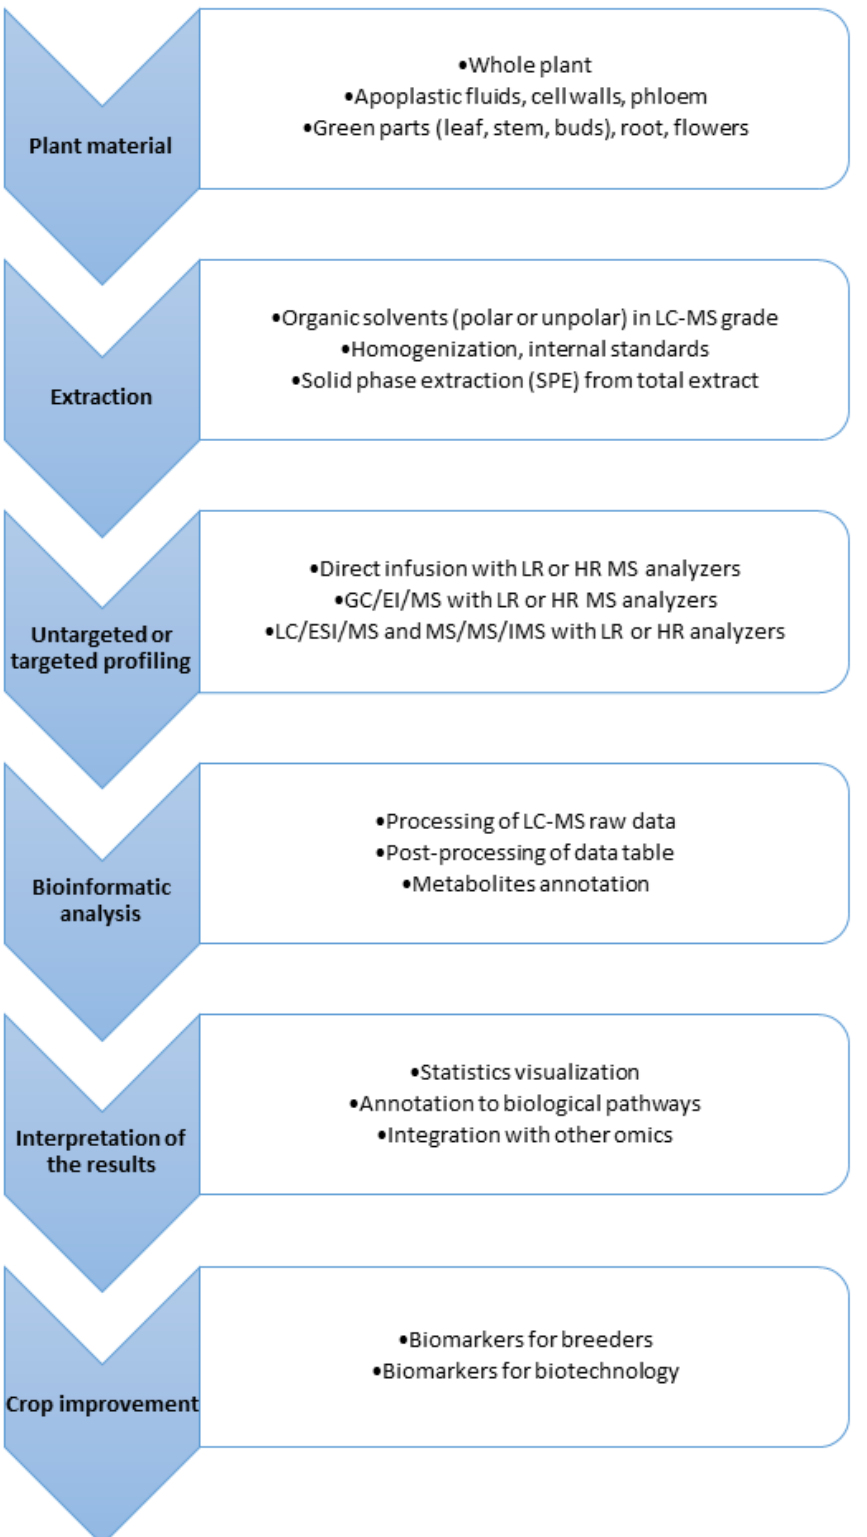
Figure 2. Mass spectrometric techniques in functional metabolomics flowchart—a useful tool for metabolome profiling and discovery alterations during abiotic and biotic stress. LR—low resolution mass spectrometers, HR—high resolution mass spectrometers.